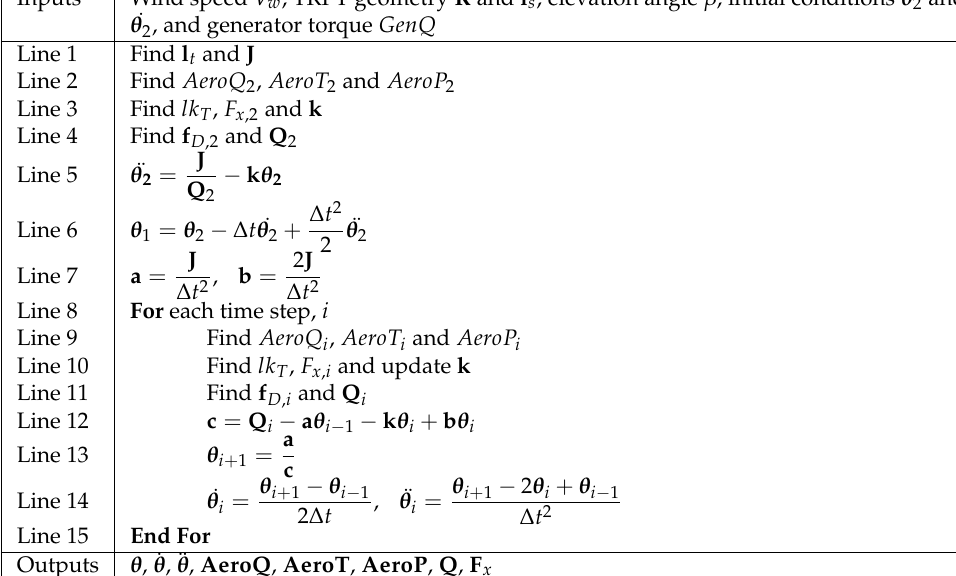
Table A1. Pseudo code for the spring-disc TRPT representation. R is the vector for the discs radii, l s is the vector containing the TRPT section lengths, l t the vector for tether lengths in each TRPT section, J is the inertia matrix, AeroQ the rotor torque, AeroT the rotor thrust, AeroP the rotor power, lk T the lift kite line tension, F x the axial force, f D the torque loss due to tether drag, Q the torque applied to each disc, k the stiffness matrix, ∆ t the time step length and θ , ˙ θ , ¨ θ the vectors containing the discs rotational positions, velocities and accelerations, respectively. a , b , and c are variables used within the